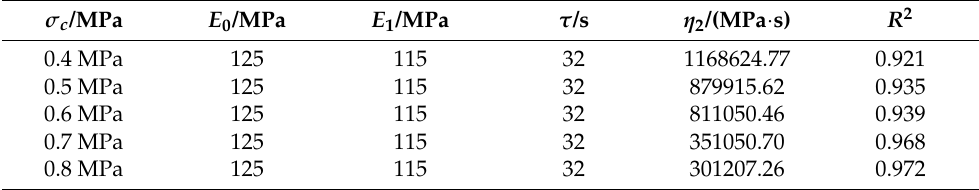
Figure 8. Model predictions vs. test data for different stresses. Table 4. The Burgers model parameters.